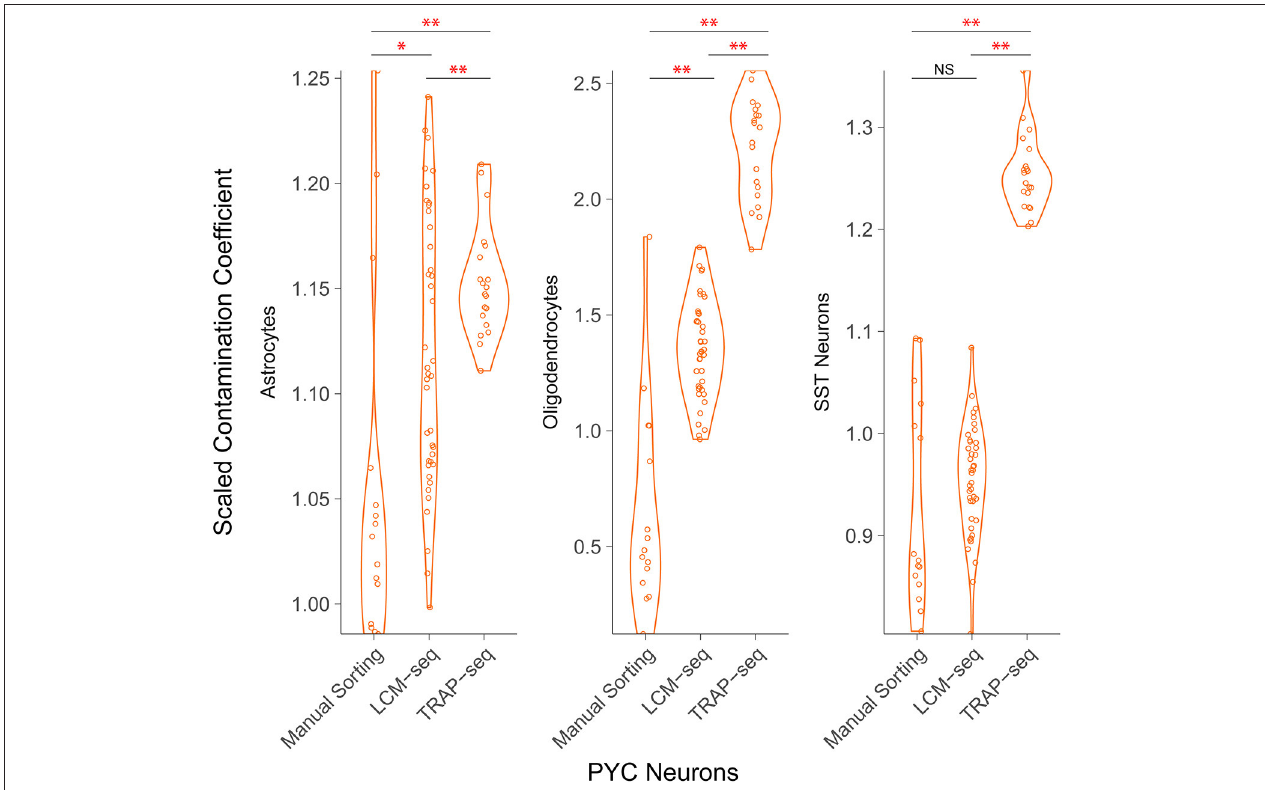
FIGURE 4 | Comparison of off-target contamination across cell purification methodologies. Estimated relative amount of off-target cellular contamination among different methodologies. Each point represents a single sample (a cell pool). Both LCM-seq datasets (Aging and Stress) were grouped, as well as both TRAP-seq datasets (Cocaine 1 and 2). The difference in mean contamination coefficients is statistically significant for most comparisons * p < 0.05, ** p < 0.01.